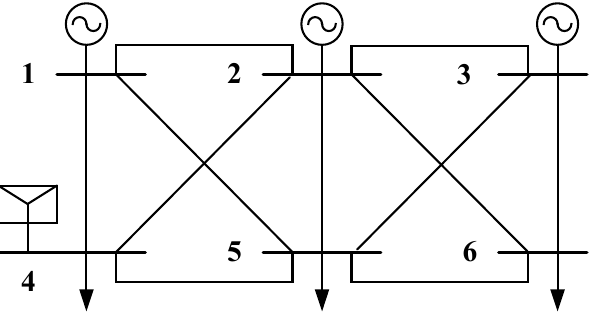
Figure 11. Generation scheme of SGs when the IBG is in VSG or MPPT mode.